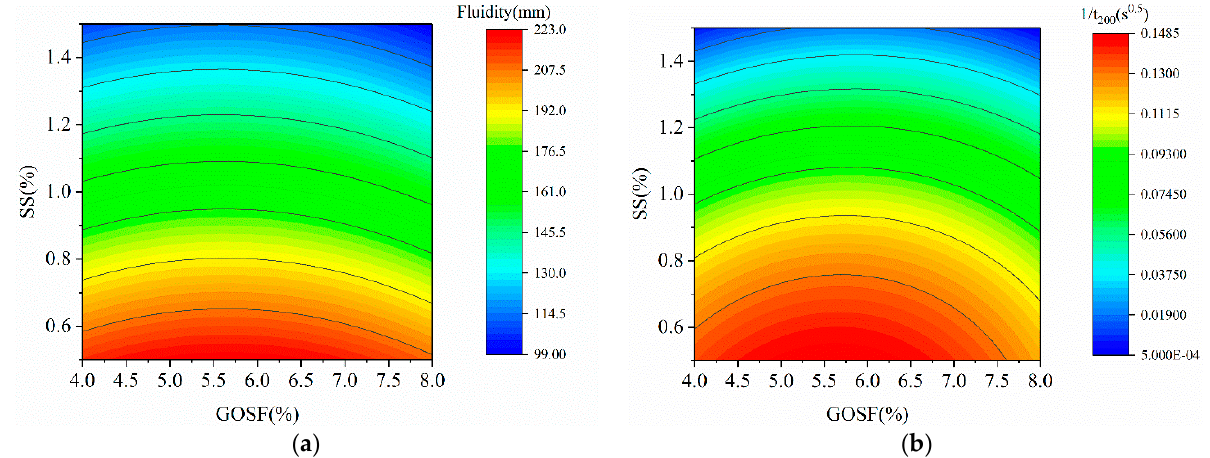
Figure 9. Fluidity ( a ) or 1/t 200 ( b ) of cement paste vs. the dosages of GOSF and SS.